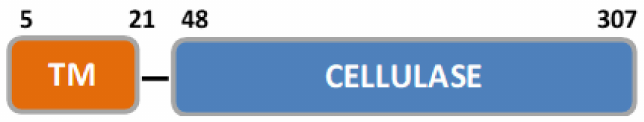
Figure 1. Domain organization of DtCel5A, based on sequence